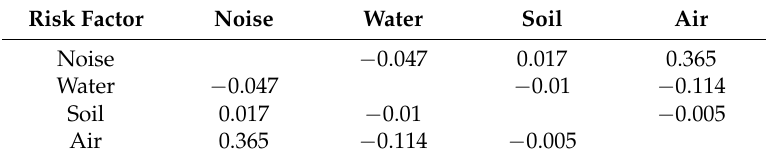
Table 2. Spearman correlation coefficients ( r ) between the different risk factor indicators estimated. Risk Factor Noise Water Soil Air Risk Factor Noise Water Soil Air Noise −0.047 0.017 0.365 Noise − −0.047 −0.01 −0.114 Soil 0.017